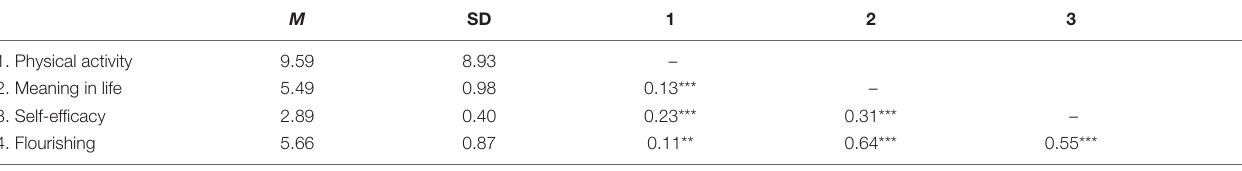
TABLE 1 | Means, SD, and correlation coefficients of major variables.